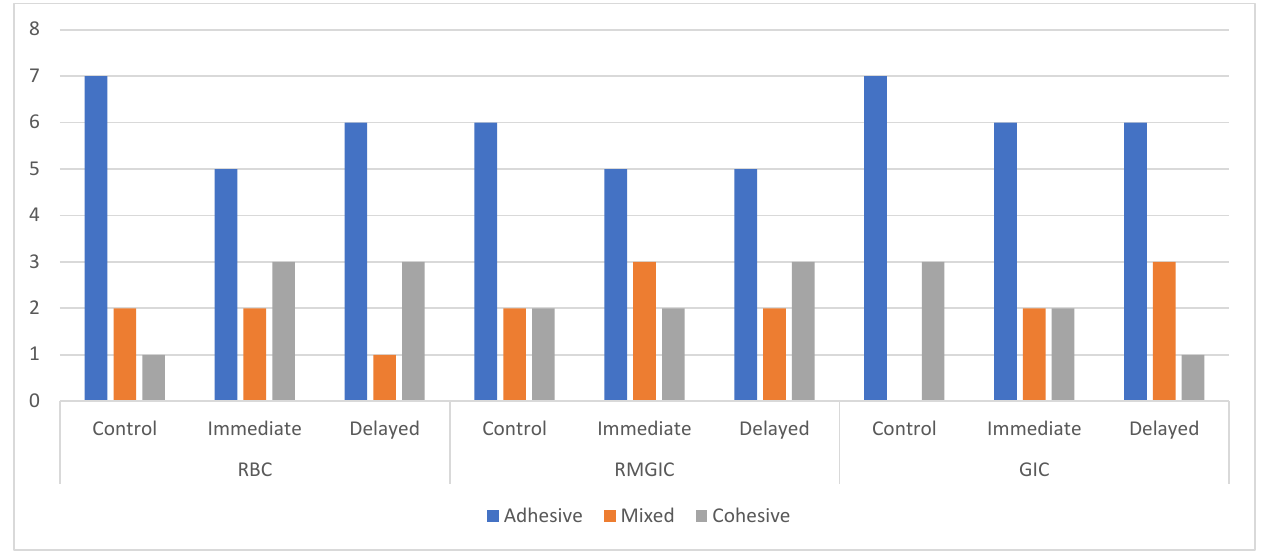
Figure 1. Failure mode distributions for each group. x axis: failure modes; y axis: number of speci-